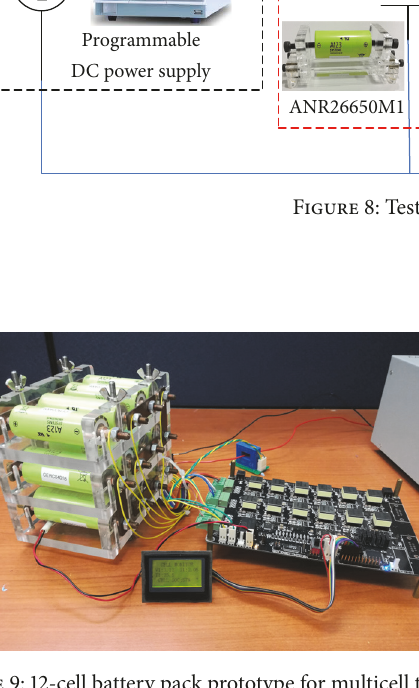
Figure 9: 12-cell battery pack prototype for multicell testing.